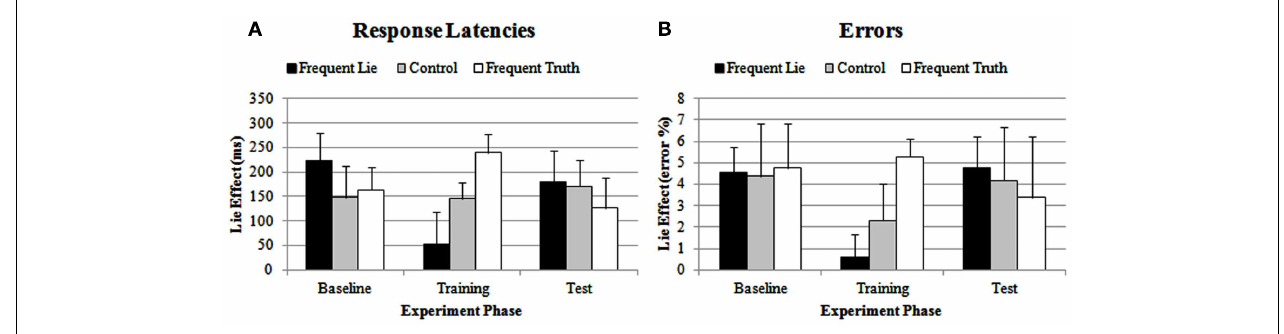
FIGURE 1 | Lie-effect of response latencies (A) and errors (B) on test trials for the frequent-lie, control, and frequent-truth group, during the baseline phase, the training phase and the test phase. Error bars represent the standard error of the mean.